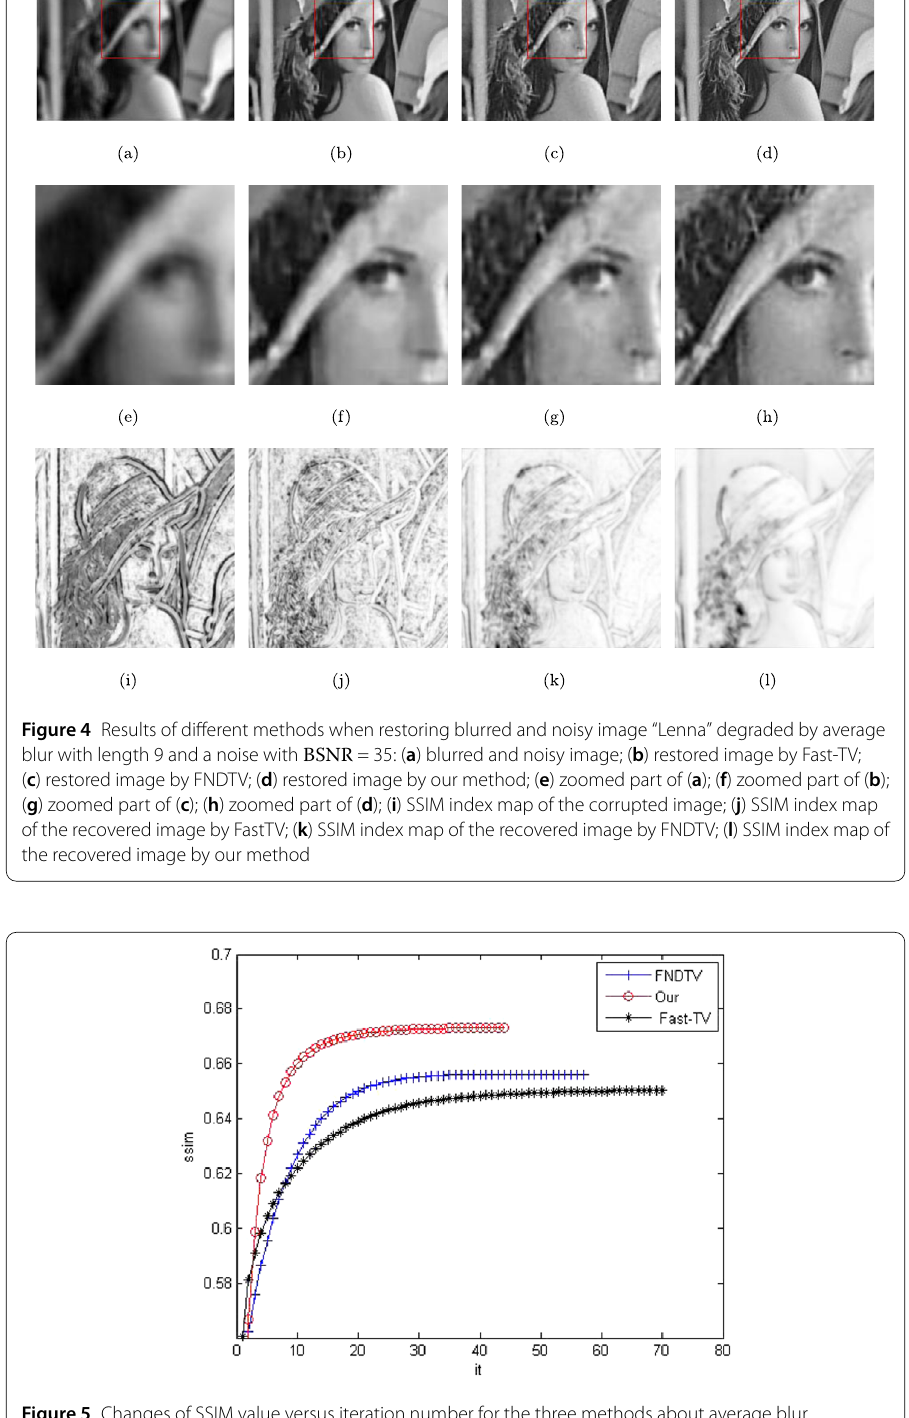
Figure 5 Changes of SSIM value versus iteration number for the three methods about average